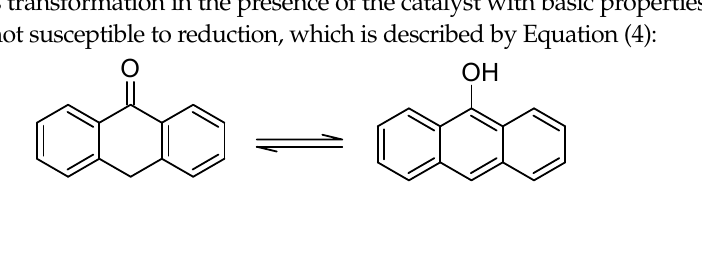
Table 5. Liquid phase transfer hydrogenation of polycyclic derivatives of cyclohexanone with sec- ondary alcohols in the presence of MgO.